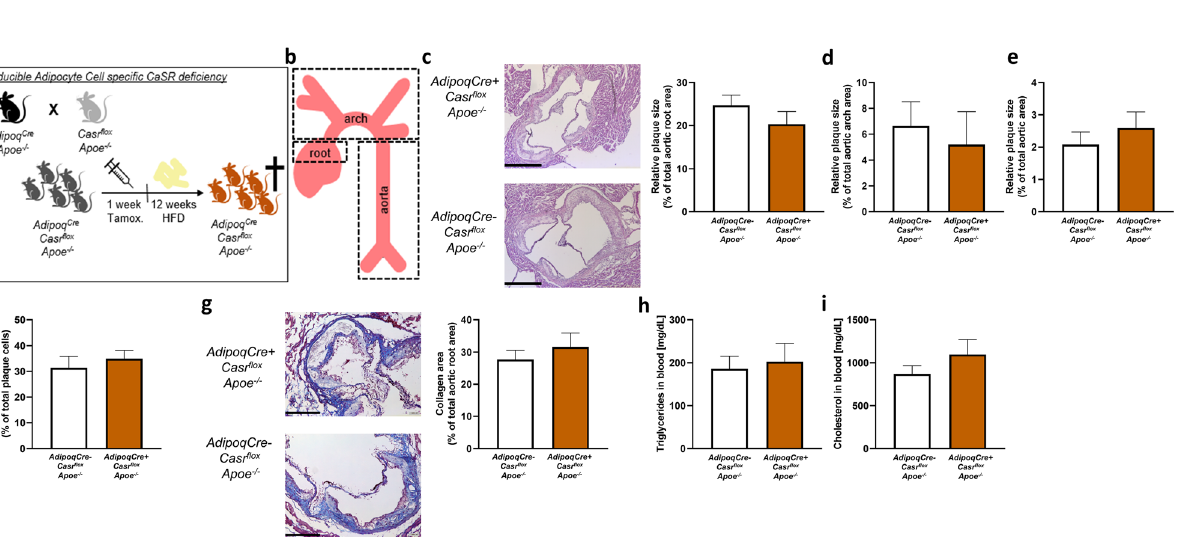
Table 1. Body weight and immune cells in blood in mice fed with HFD for 4 weeks. Analysis has been done using FACS Diva software 8.0.3 (www. bdbio scien ces. com) and FlowJo 10.7 (www. flowjo. com).